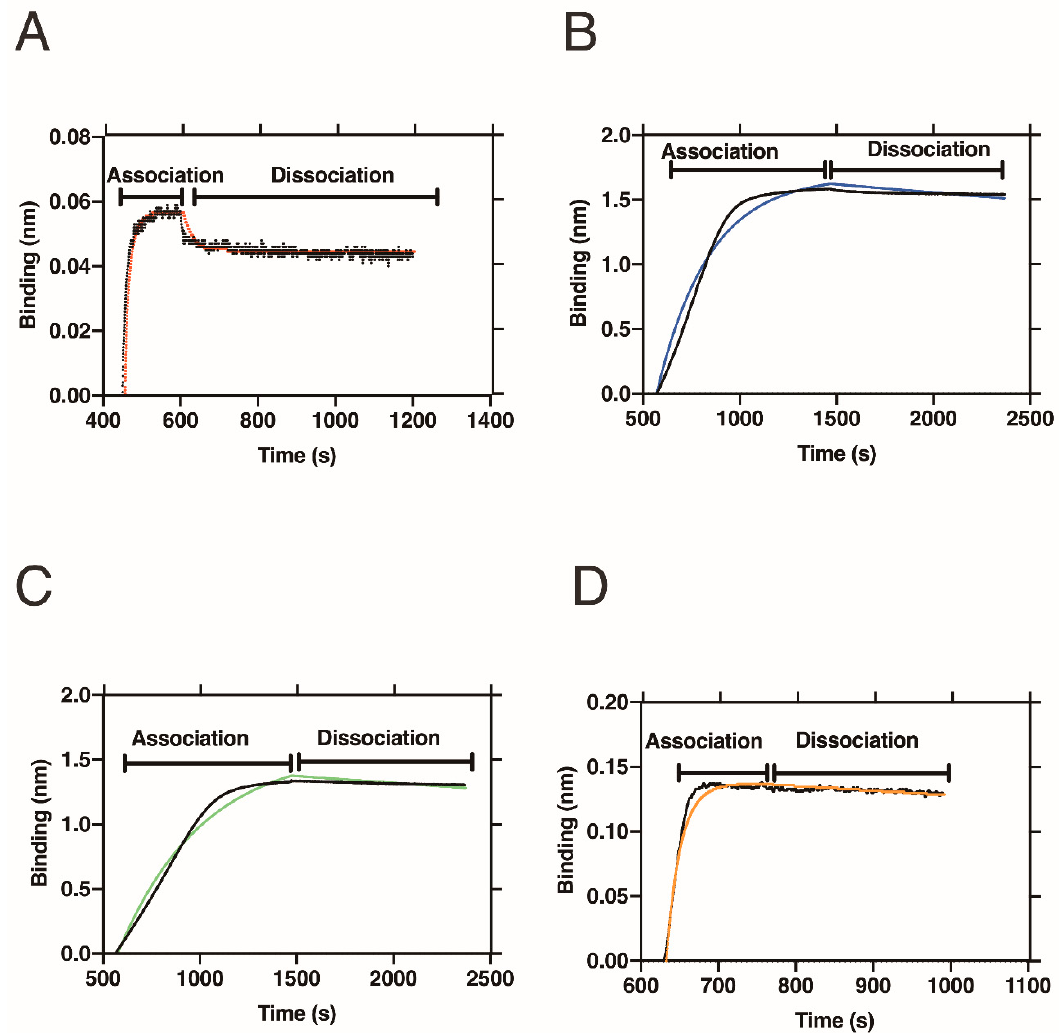
Figure 4. BLI data for binding of ( A ) folate-PEG 8 -biotin, ( B ) GF Z IQ, ( C ) SE Z KA and ( D ) DSE Z KAY with FR α . In all cases, analyte only data was kept as a reference and 1:1 local analysis was used. The black curve lines are run data and colored curve lines are fitting data.